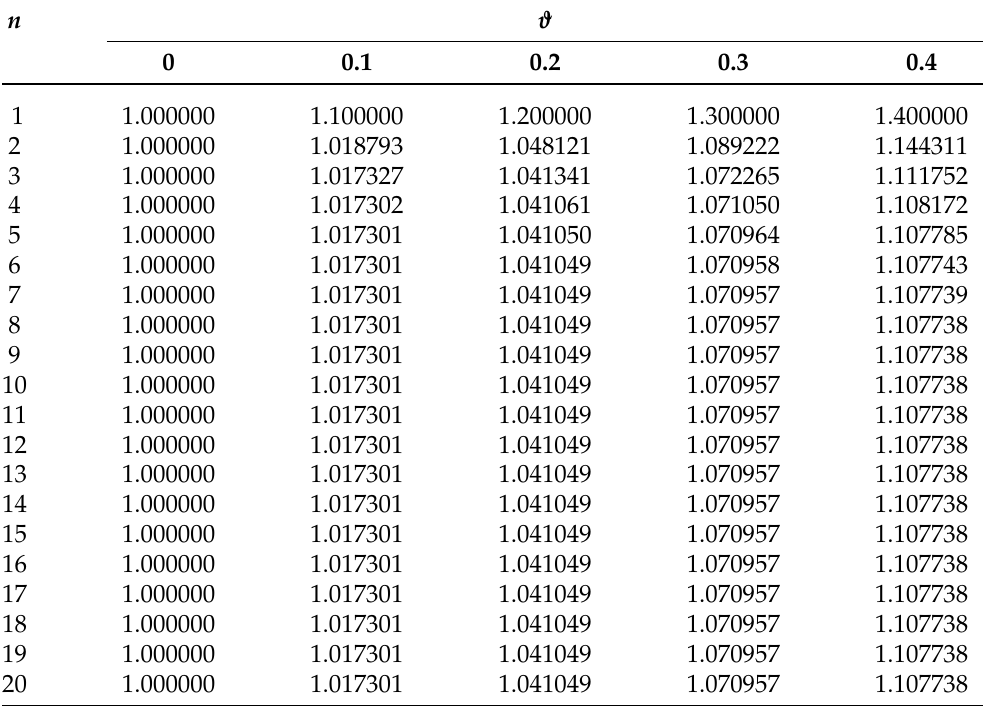
Table 3. Numerical results of ˜ z n + 1 ( ϑ ) for n = 1,2, . . . ,20 and ϑ = 0, 0.1, 0.2, 0.3, 0.4 by using (22) in Example